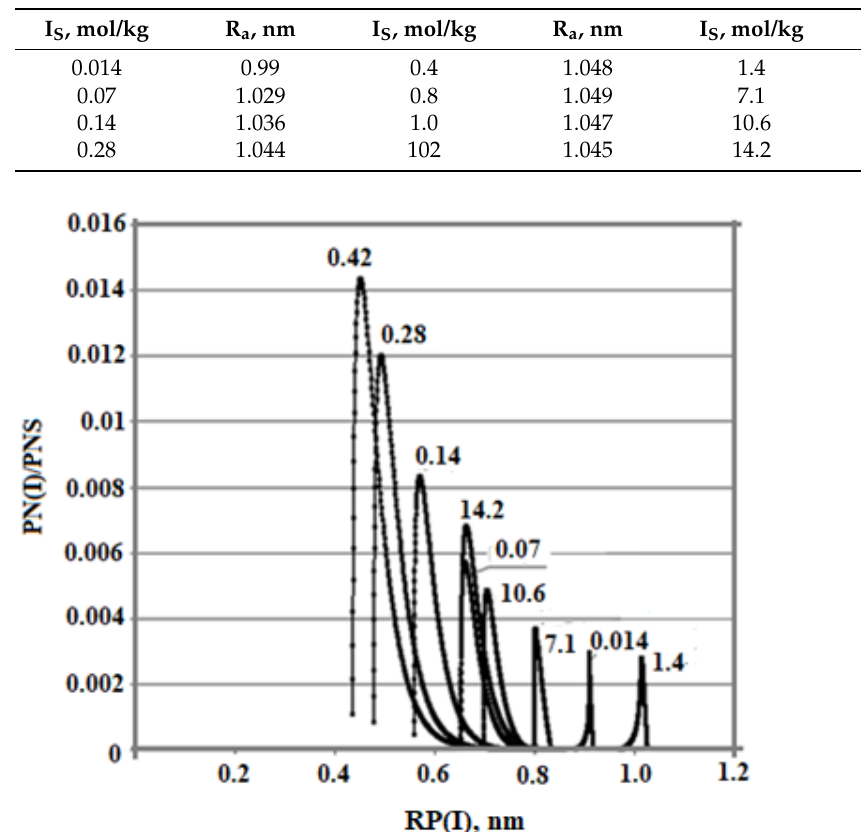
Figure 8. Particle size distribution with different ionic strength values. t = 20 °C, pH = 8.0, and initial concentration C s = 700 mg/kg, I s (mol/kg).